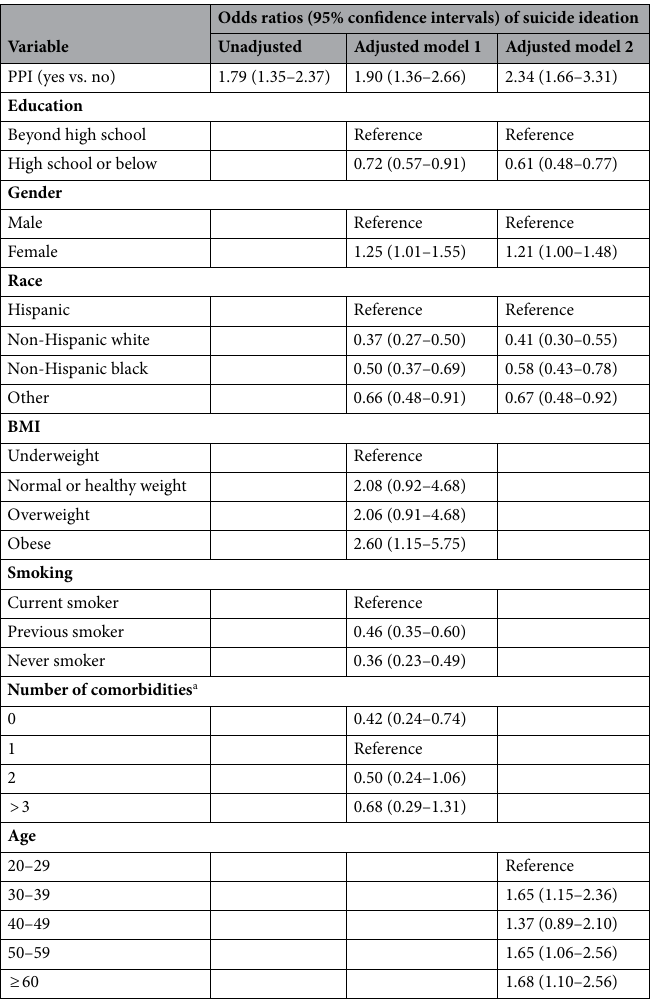
Table 2. Weighted and adjusted odds ratios of PPI use and covariates with suicide ideation in 16,881 participants, NHANES 2005–2018. a Comorbidities included angina, coronary heart disease, heart failure, myocardial infarction and